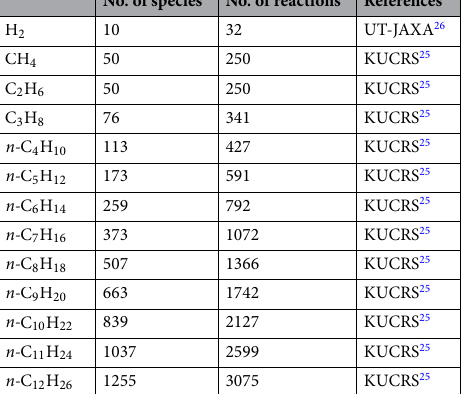
Table 1. Numbers of species and elementary reactions in detailed reaction